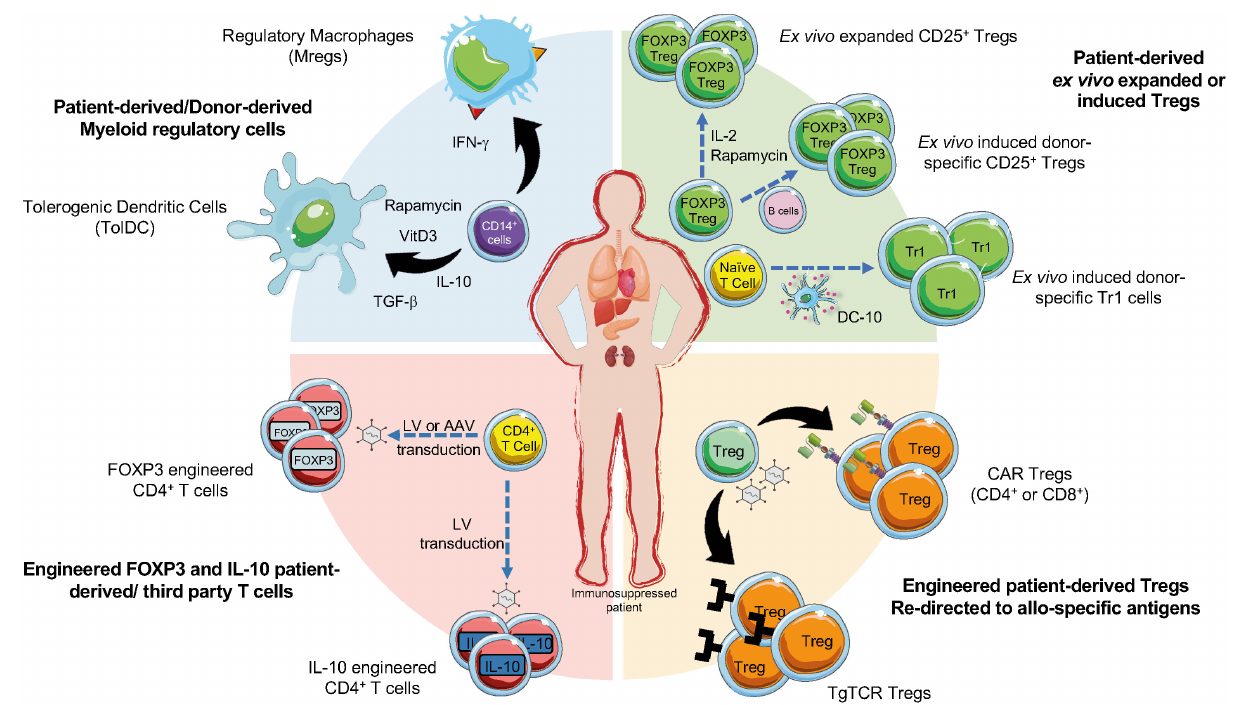
FIGURE 1 | Current cell-based strategies in organ transplantation. Regulatory T cells (Tregs), regulatory myeloid cells (MRCs), and engineered Tregs have been applied as cell-based therapy to promote tolerance in pharmacological immunosuppressed patients undergoing organ transplantation. Ex vivo expanded Tregs can be generated in presence of different agents (e.g., IL-2, or Rapamycin). Donor-specific Tregs can be generated upon activation with CD40L-activated B cells and then expanded, CD4 + T cells co-cultured with allogeneic DC-10 differentiate into allo-specific Tr1 cells (green sector). Allo-specific redirected Tregs can be induced through the transduction with CARs or transgenic TCR (orange sector). The production of engineered FOXP3 and IL-10 overexpressing Tregs can be obtained by the transduction of CD4 + T cells with lentiviral vectors (LV) or adenoviral vectors (AAV) encoding for IL-10 or FOXP3 (red sector). MRCs, tolerogenic DC (TolDC) or regulatory macrophages (Mregs), are differentiated from CD14 + cells through exposure to immunomodulatory agents (e.g., IL-10, TGF- β , Rapamycin, Vitamin D3) (blue